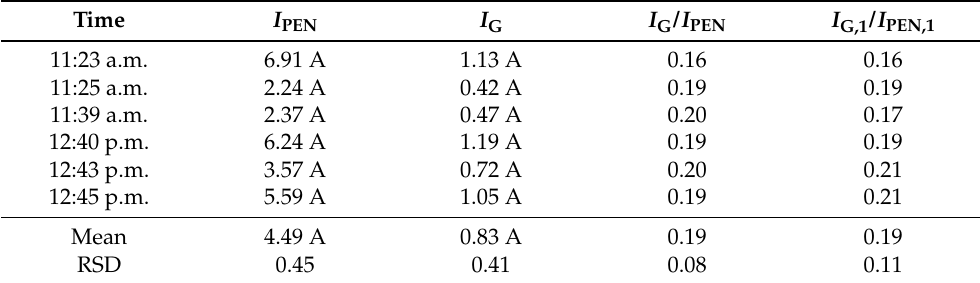
Table 2. Time dependency of current measurements at substation A, feeder 2.